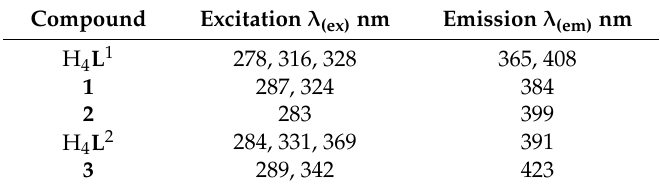
Table 2. Solid-state PL of Ligands (H 4 L 1 and H 4 L 2 ) and Complexes 1 – 3